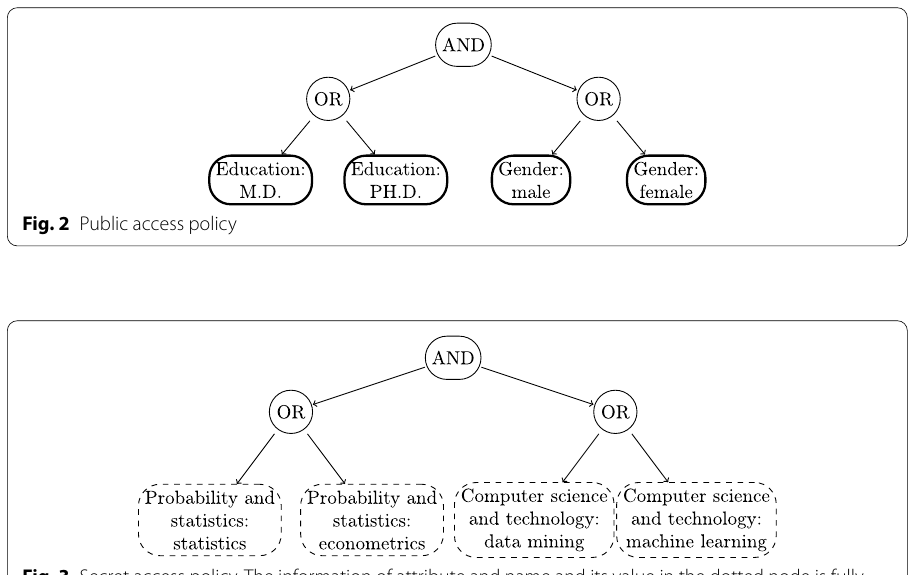
Fig. 3 Secret access policy. The information of attribute and name and its value in the dotted node is fully the ciphertext, and the privacy of the sensitive access policy is preserved from unauthor- ized end users. The contribution of our scheme is shown as follows.